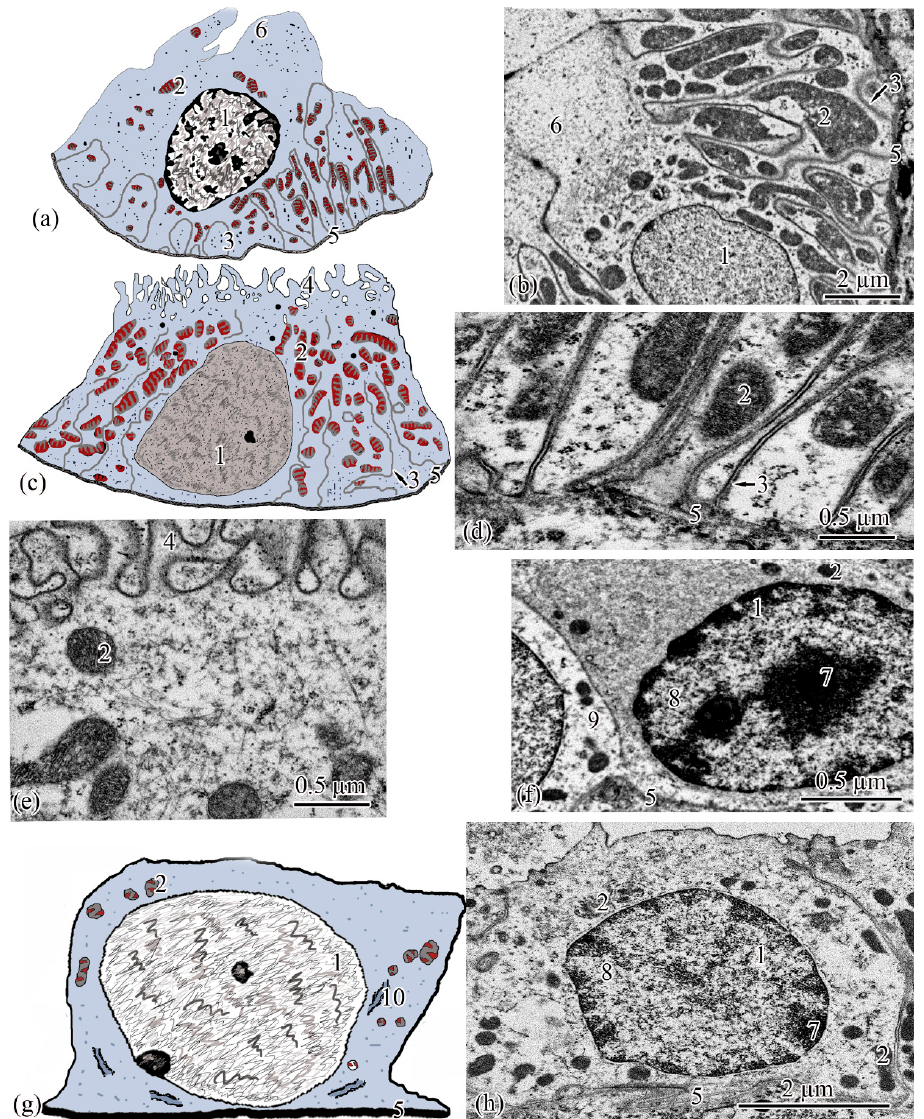
Figure 6. Ultrastructure of the distal tubule and of the connecting tubule. Type I epithelial cell of the distal tubule scheme ( a ); type I epithelial cell of the distal tubule ( b ); type II epithelial cell of the distal tubule scheme ( c ); basal part of type II epithelial cell of the distal tubule ( d ); apical part of type II epithelial cell of the distal tubule ( e ); dark epithelial cell of the connecting tubule ( f ); epithelial cell of the connecting tubule scheme ( g ); light epithelial cell of the connecting tubule ( h ). Cell units: nucleus (1), mitochondria (2), smooth endoplasmic reticulum (3), microvilli (4), basement membrane (5), lobed cytoplasmic process (6), heterochromatin (7), euchromatin (8), part of dark epithelial cell of the connecting tubule (9), cisterns of the rough endoplasmic reticulum (10). Type I epitheliocytes of the distal tubule are the highest; they are 21.24 ± 0.07 µ